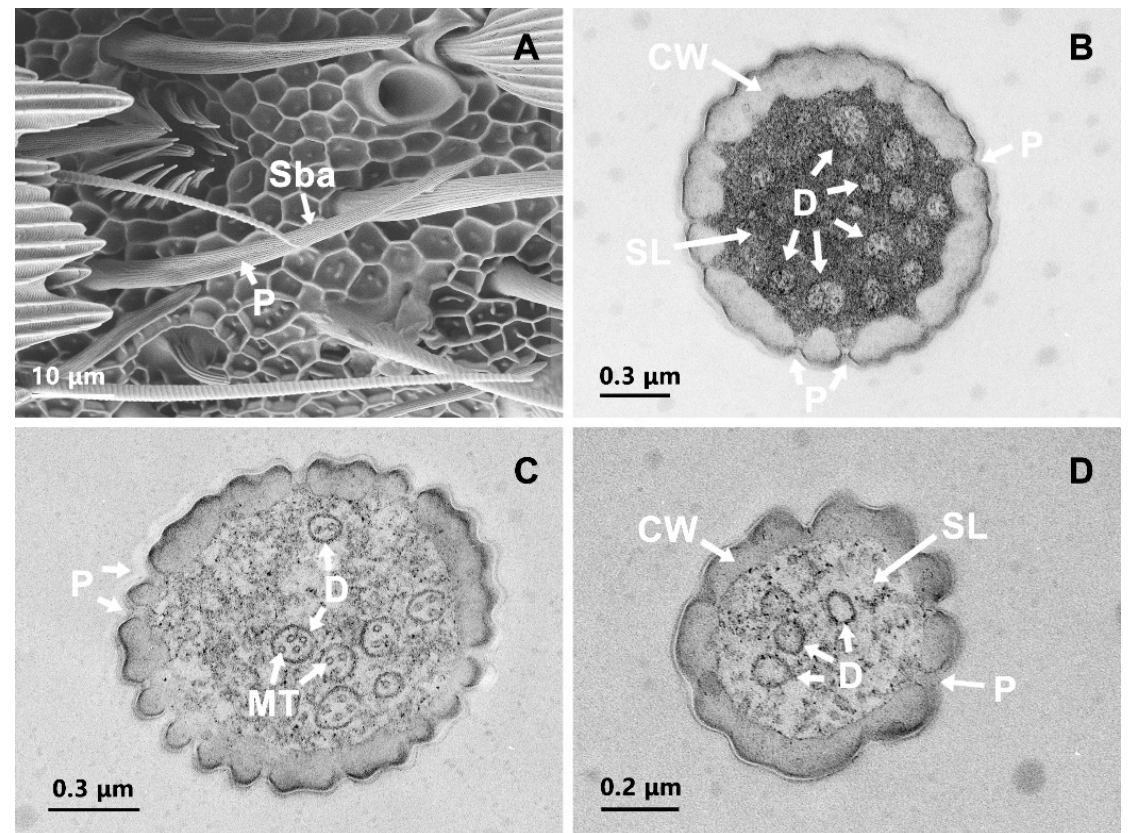
Figure 5. Scanning electron micrographs and transmission electron micrographs of sensilla basiconica (Sba). ( A ) The surface structure of Sba. ( B ) transverse section through the basal section of Sba. ( C ) transverse section through the middle part of Sba. ( D ) transverse section through the distal part of Sba. CW: cuticle wall; D: dendrite; MT: microtubule; SL: sensilla lymph; P: pore.